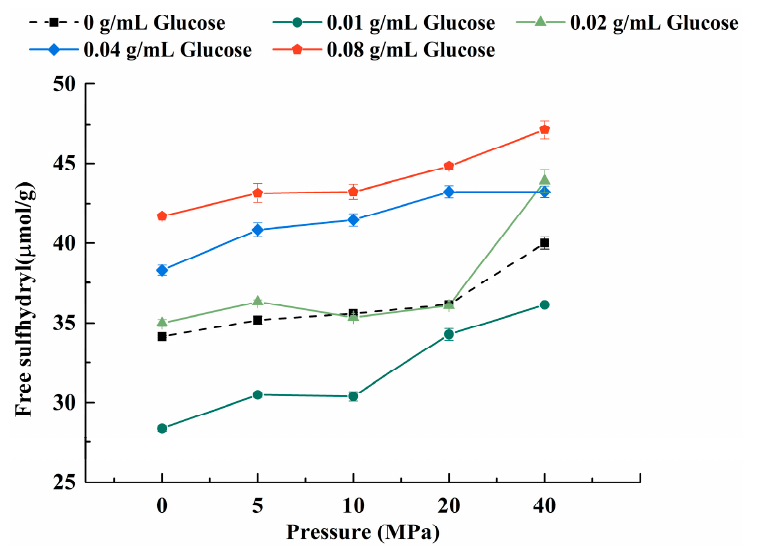
Figure 3. The free sulfhydryl content of LWE under different homogenization pressure treatment and glucose concentrations.